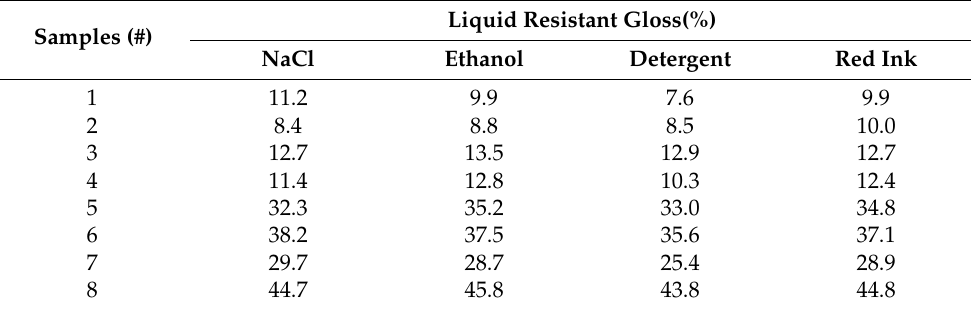
Influence of coating processes on liquid resistant gloss of waterborne coating containing